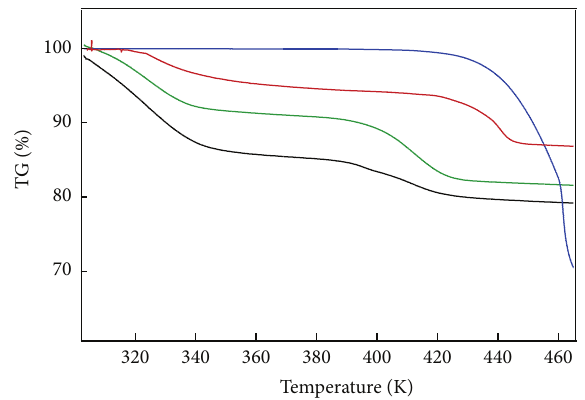
Figure 3: TG curves for the nanocomposites. Blue: KHCO 3 , black: 7CA–KC, green: 16CA–KC, and red: 18CA–KC.